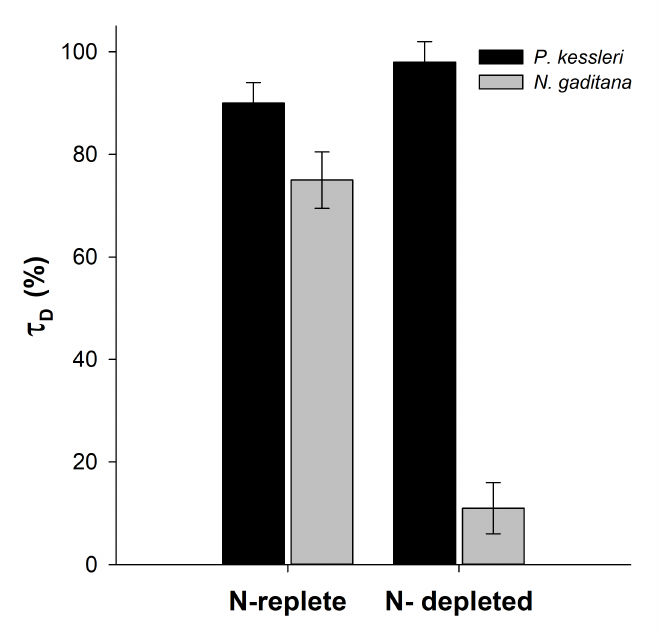
Figure 2. Comparison of cell disruption (at 1750 bar) for N. gaditana and P. kessleri [30] in two physiological states.